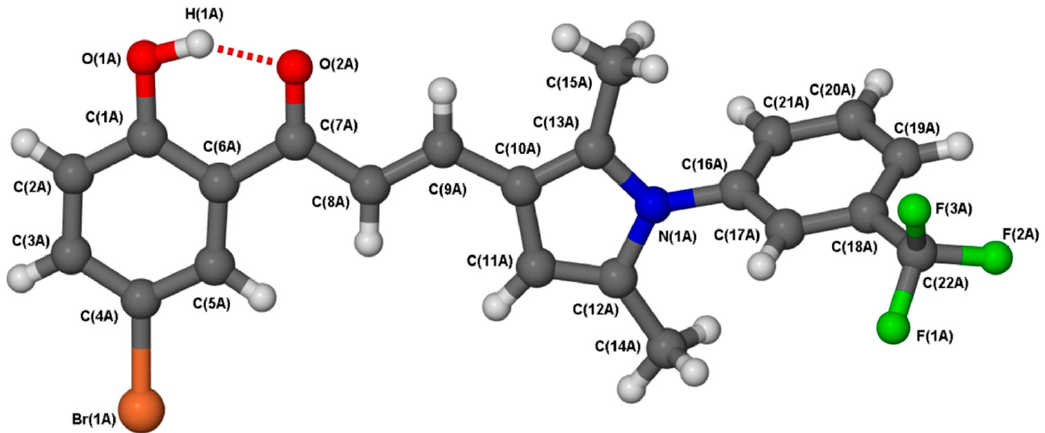
Figure 3. Molecular structure of 10e depicting the numbering scheme and the intramolecular hydrogen bond (shown here by the red dashed line). The hydrogen atoms on carbons were fixed in geometrically calculated while those bound to oxygen were freely refined. The structure was solved and refined to a final residual factor R 1 = 0.0751. All non-hydrogen atoms were refined anisotropically, with the ellipsoids drawn at the 50% probability level (see Figure S1 in the Supplementary Materials). From the structure of 10e , bond lengths and bond angles are comparable to chalcone derivatives, which have been reported in the literature [48]. The existence of an α , β -unsaturated ketone is further confirmed by short O(2A)-C(7A) and C(8A)-C(9A) bond lengths of 1.244(7) Å and 1.359(6) Å, ◦ ◦ respectively; and bond angles O(2A)-C(7A)-C(8A) and C(7A)-C(8A)-C(9A) of 121.2(5) and 120.8(4) , respectively. More importantly, the structure exhibits intramolecular hydrogen bonding between the hydroxyl oxygen of ring A and the ketone adjacent to ring A. Introduction of intramolecular hydrogen bond (IMHB) into the bioactive compounds has been reported to have beneficial e ff ects, of benzimidazoles containing an IMHB structural feature showing in vitro antiplasmodial activity against chloroquine-sensitive (NF54) and multi-drug resistant (K1) strains of the malaria parasite Plasmodium falciparum [50]. The aryl moiety on ring B of the chalcone is rotated about the N(1A)-C(16A) bond with corresponding four torsion angles (Figure S2). The observed torsion angles suggest the deviation from planarity of the aryl group attached to the pyrrole framework. The crystal packing (Figure 4) of the molecule is stabilized by π - π stacking interactions between phenyl rings ( A ) and between the phenyl and pyrrole rings ( B ). The centroid-to-centroid distances ( A , B ) are approximately 3.927(3) Å and 3.731(2) Å, which further confirms the intermolecular π - π stacking interactions